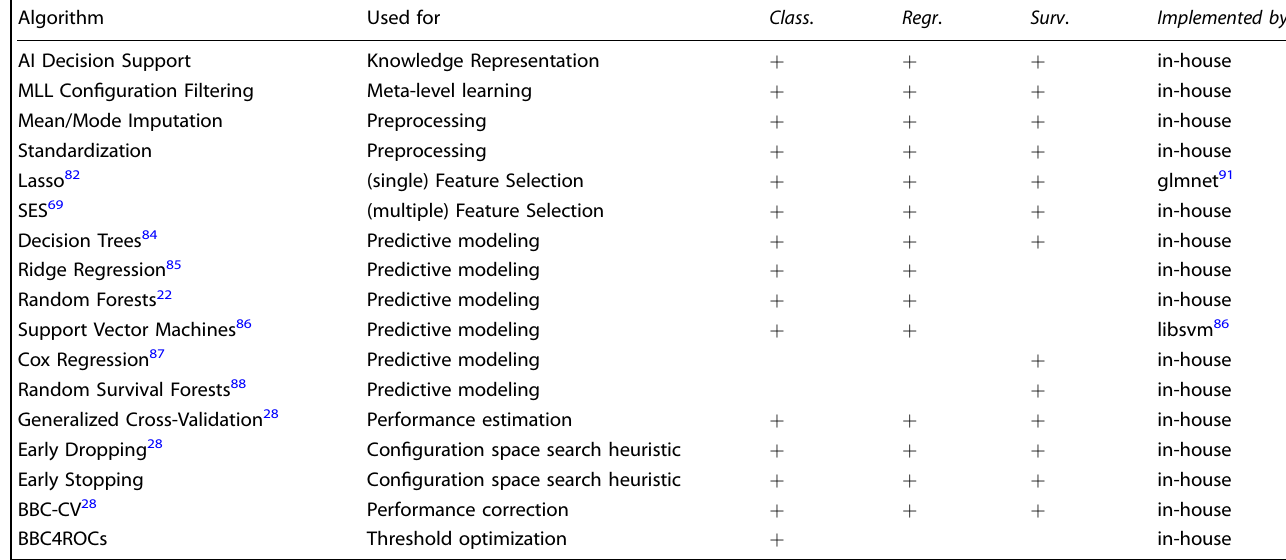
Table 2. Algorithms used by JADBio depending on the outcome of interest.